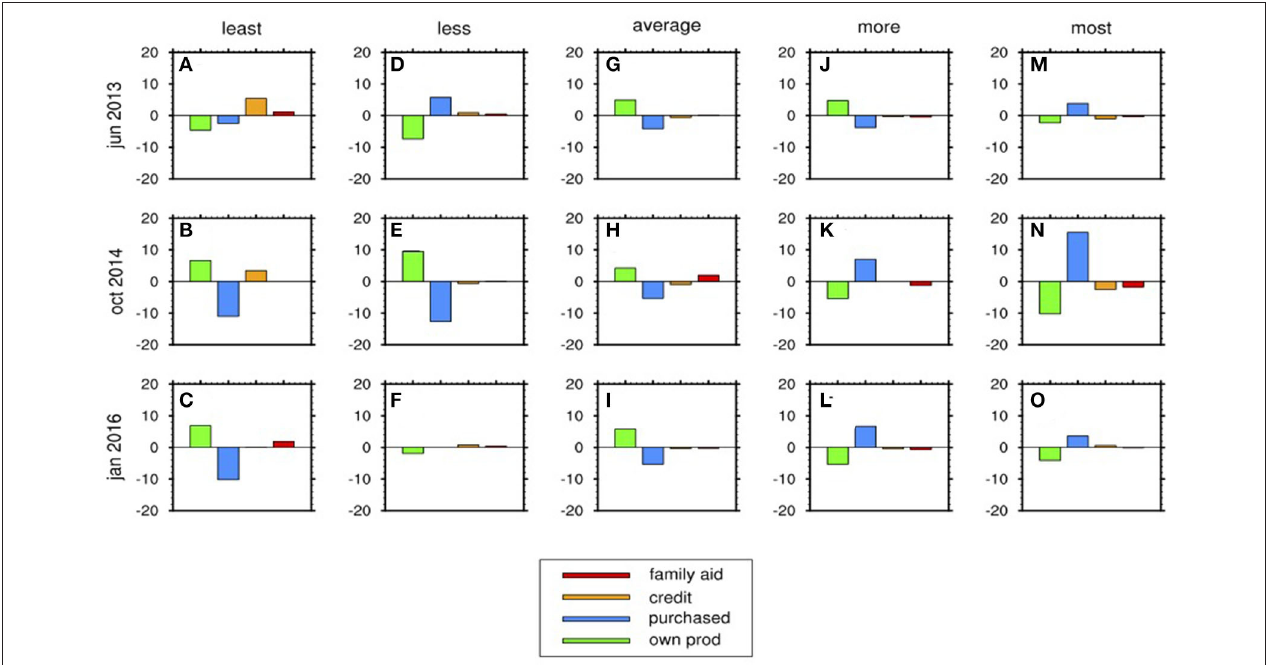
FIGURE 5 | Anomalies , with respect to the all-rural household average in Figure 4 (“other cereals,” that is, D–F ), in the primary source of other cereals consumed, by cluster. Each row is a survey, 2013–2016 from top to bottom (A,D,G,J,M; B,E,H,K,N; C,F,I,L,O) . Each column is a cluster, least (A–C) to most food secure (M–O) from left to right. “Anomaly” here means the difference between values differentiated by cluster and the “all households” values depicted in Figure 4